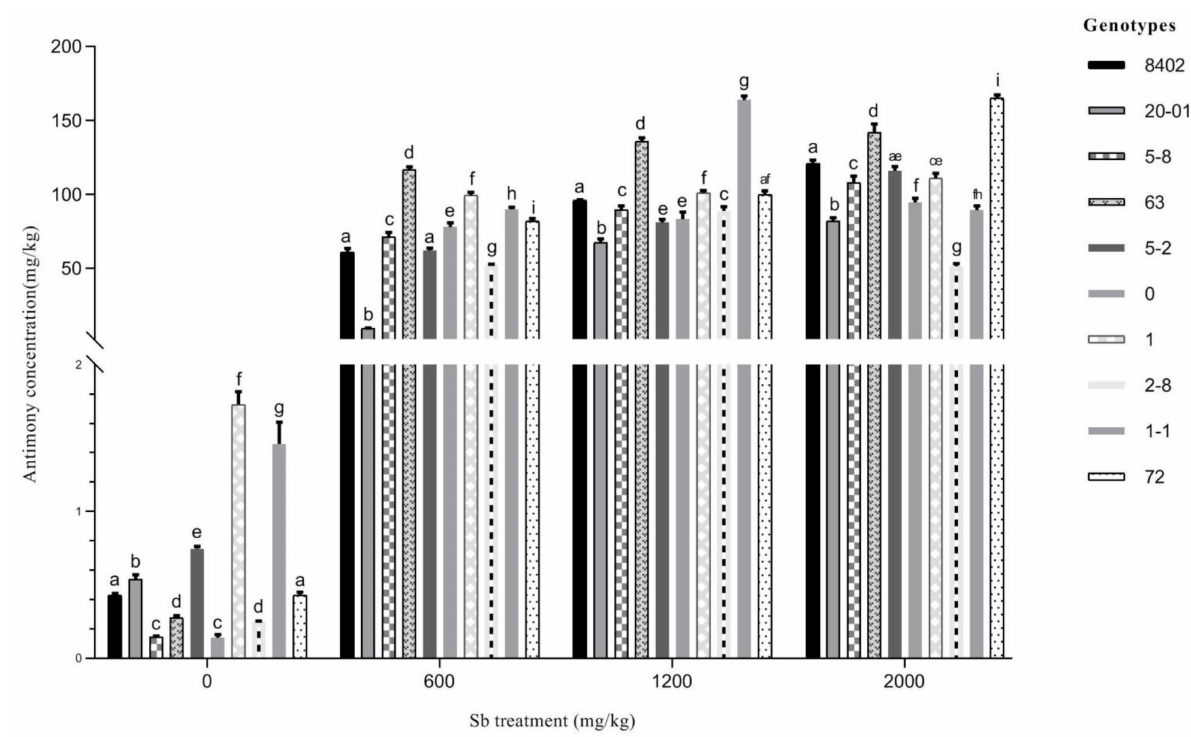
Figure 7. Sb concentration in leaves of Catalpa bungei. Note: Different letters indicate significant differences among the treatments at p < 0.05 ( n =